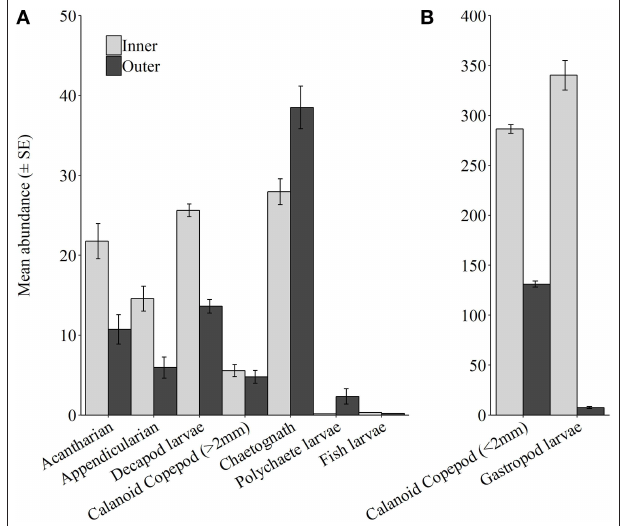
FIGURE 8 | Mean abundance ( ± SE) for common taxa and/or taxa of ecological interest, at Inner and Outer stations across all atolls. (A) Taxa group 1, (B) Taxa group 2, Taxa have been separated into groups for graphical